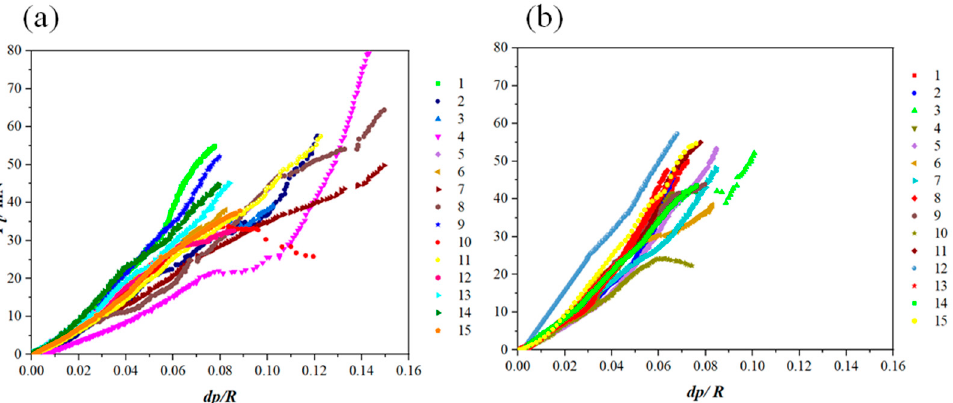
Figure 8. F l ( d p /R ) curves extracted from the nano-scratch results applied on ( a ) the reference coatings and ( b ) the Al 2 O 3 -ZrO 2 coatings.